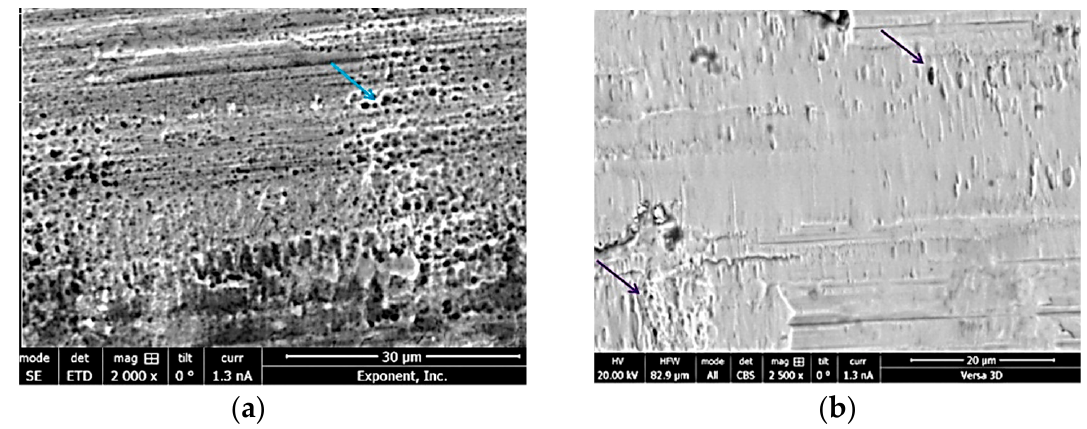
Figure 6. ( a ) SEM image of the fretting damage (blue arrow) on the head surface in the valleys of microgrooved junctions. ( b ) SEM analysis confirms the smeared fretting damage (purple arrows) on the head surface in the smooth junctions [30].